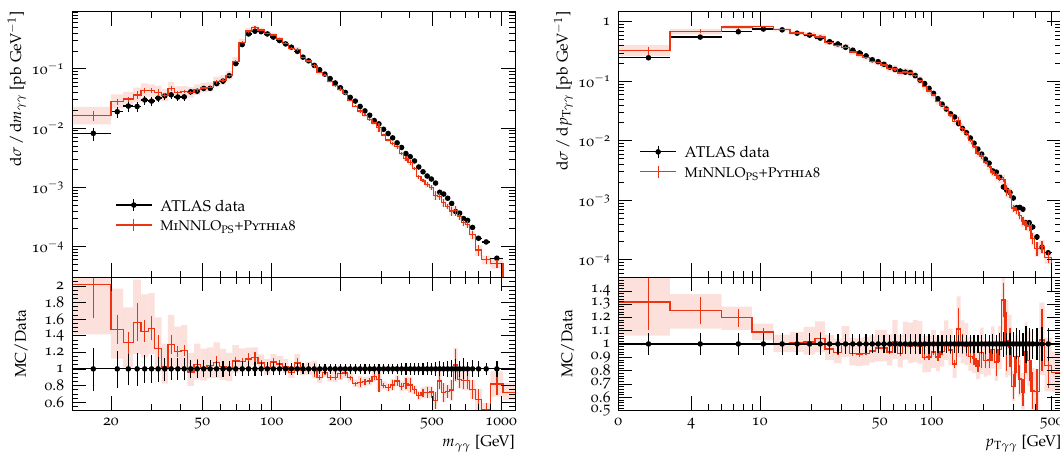
Figure 9 . Comparison between the ATLAS data and the distributions obtained with MiNNLO Pythia8 , for the diphoton invariant mass and its transverse momentum. Scale- PS + variation bands are also shown, together with the statistical errors of the central value.